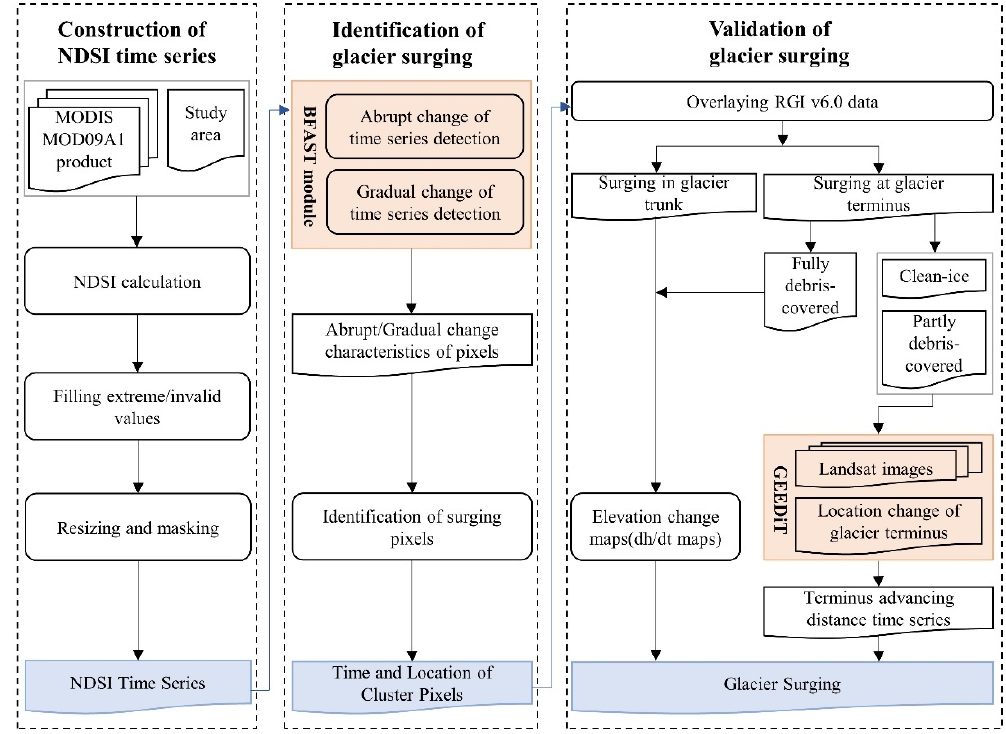
Figure 2. Workflow of proposed method for identification and validation of surge ‐ type glaciers.